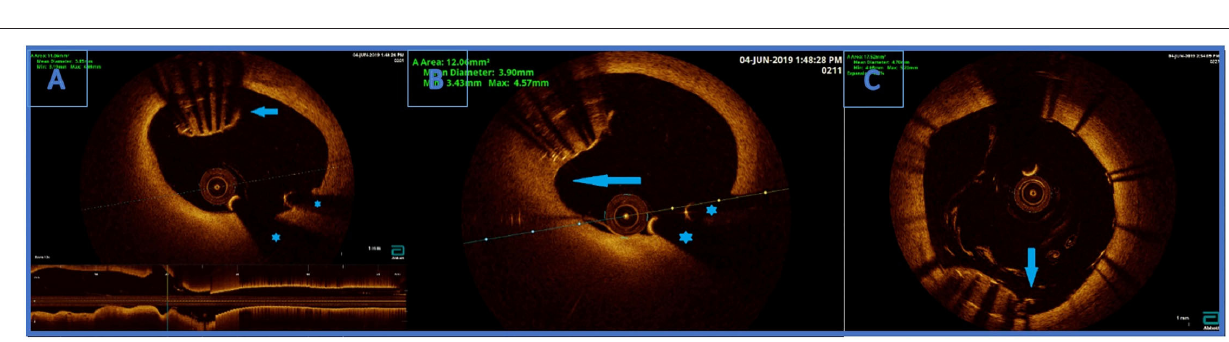
FIGURE 3 | (A) Optical coherence tomography (OCT) finding an undeployed part of the lost stent in the left main artery. There are no signs of thrombosis around the stent. Below is the longitudinal view of the left main OCT. * Wire artifacts. (B) Optical coherence tomography image. Partially endothelialised (arrow) part of the undeployed stent in the LM. (C) OCT showing good apposition of the new stent and a successfully crushed part of the undeployed stent. Arrow indicating a single non fully apposed